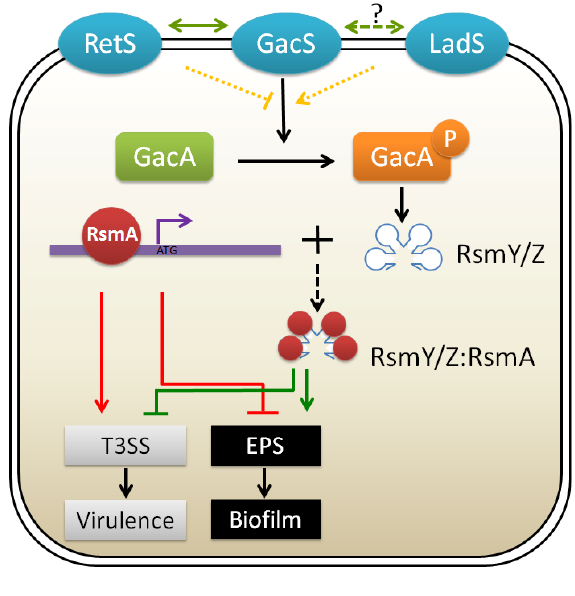
Figure 3. Schematic diagram of the two-component system regulation of biofilm formation and virulence in P. aeruginosa [95,96,100,104]. Unknown environmental cues received by the input domains of the three membrane-associated sensor kinases (GacS, LadS and RetS) activate or repress the expression of genes necessary for acute or chronic infection. Free regulatory protein RsmA can bind to the promoter regions of multiple genes, thus repressing expression of biofilm associated genes such as psl locus and enhancing bacterial motility and the production of several acute virulence factors ( Red lines ). When the response regulator GacA is phosphorylated by the upstream sensor kinase GacS, the production of small regulatory RNAs RsmZ and RsmY are stimulated, followed by the titrating to RsmA protein, which ultimately de-represses the expression of biofilm-related genes and represses the production of virulence-related factors ( Green lines ). The signaling cascade going through RetS, operating in an opposite manner to that of GacS and LadS, generates more free RsmA, resulting in T3SS activation and biofilm repression ( Red lines ). T3SS, type 3 secretion system. EPS, exopolysacchrides. P means phosphorylated state of GacA. Dark red circle indicates RsmA protein, which binds to the genomic DNA without environmental stimulation and binds to RsmY or RsmZ when the upstream pathways are